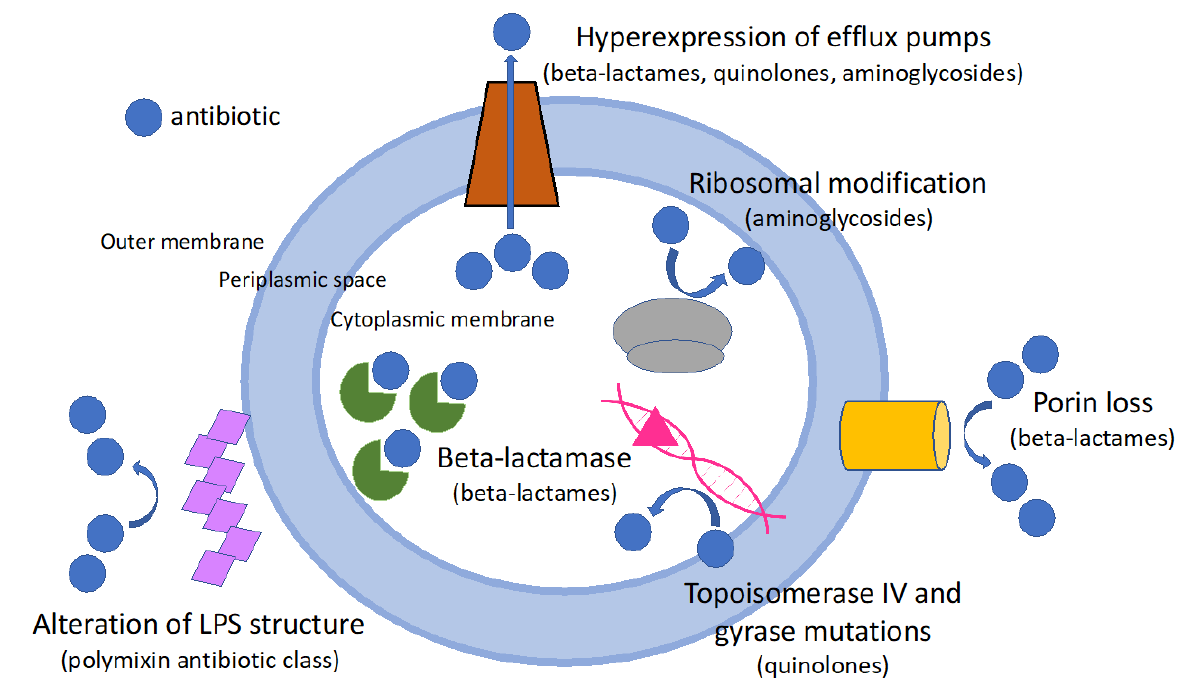
Figure 1. Mechanisms of antibiotic resistance of P. aeruginosa . LPS: lipopolysaccharide. 2.2. Respiratory Tract Colonization by P. aeruginosa in Lung Transplant Recipients: To Eradicate or Not?